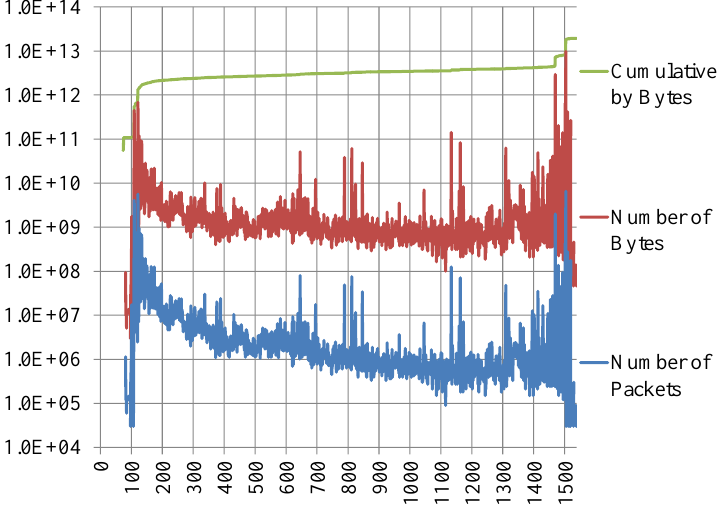
Figure 12. Captured traffic of Ethernet packets.